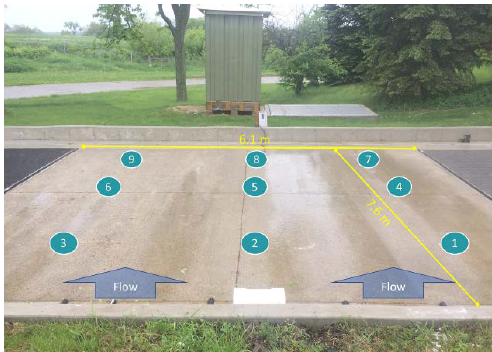
Figure 3. Layout of discrete test locations for a surface infiltration test at the permeable pavement test site (pervious concrete shown; numbers indicate the designated label for each discrete location).